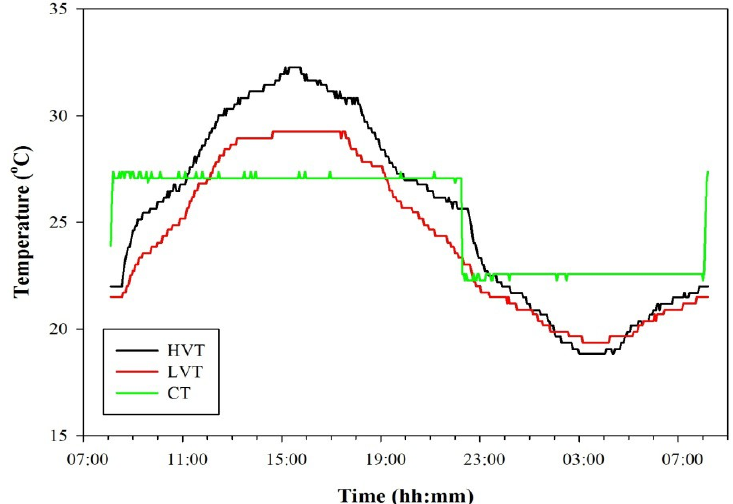
Figure 2. The actual temperature for the two oscillation patterns and the fixed temperature regime with the same accumulated temperature. LVT is the low-temperature oscillation pattern, HVT is the high-temperature oscillation pattern, and CT is a constant temperature condition.